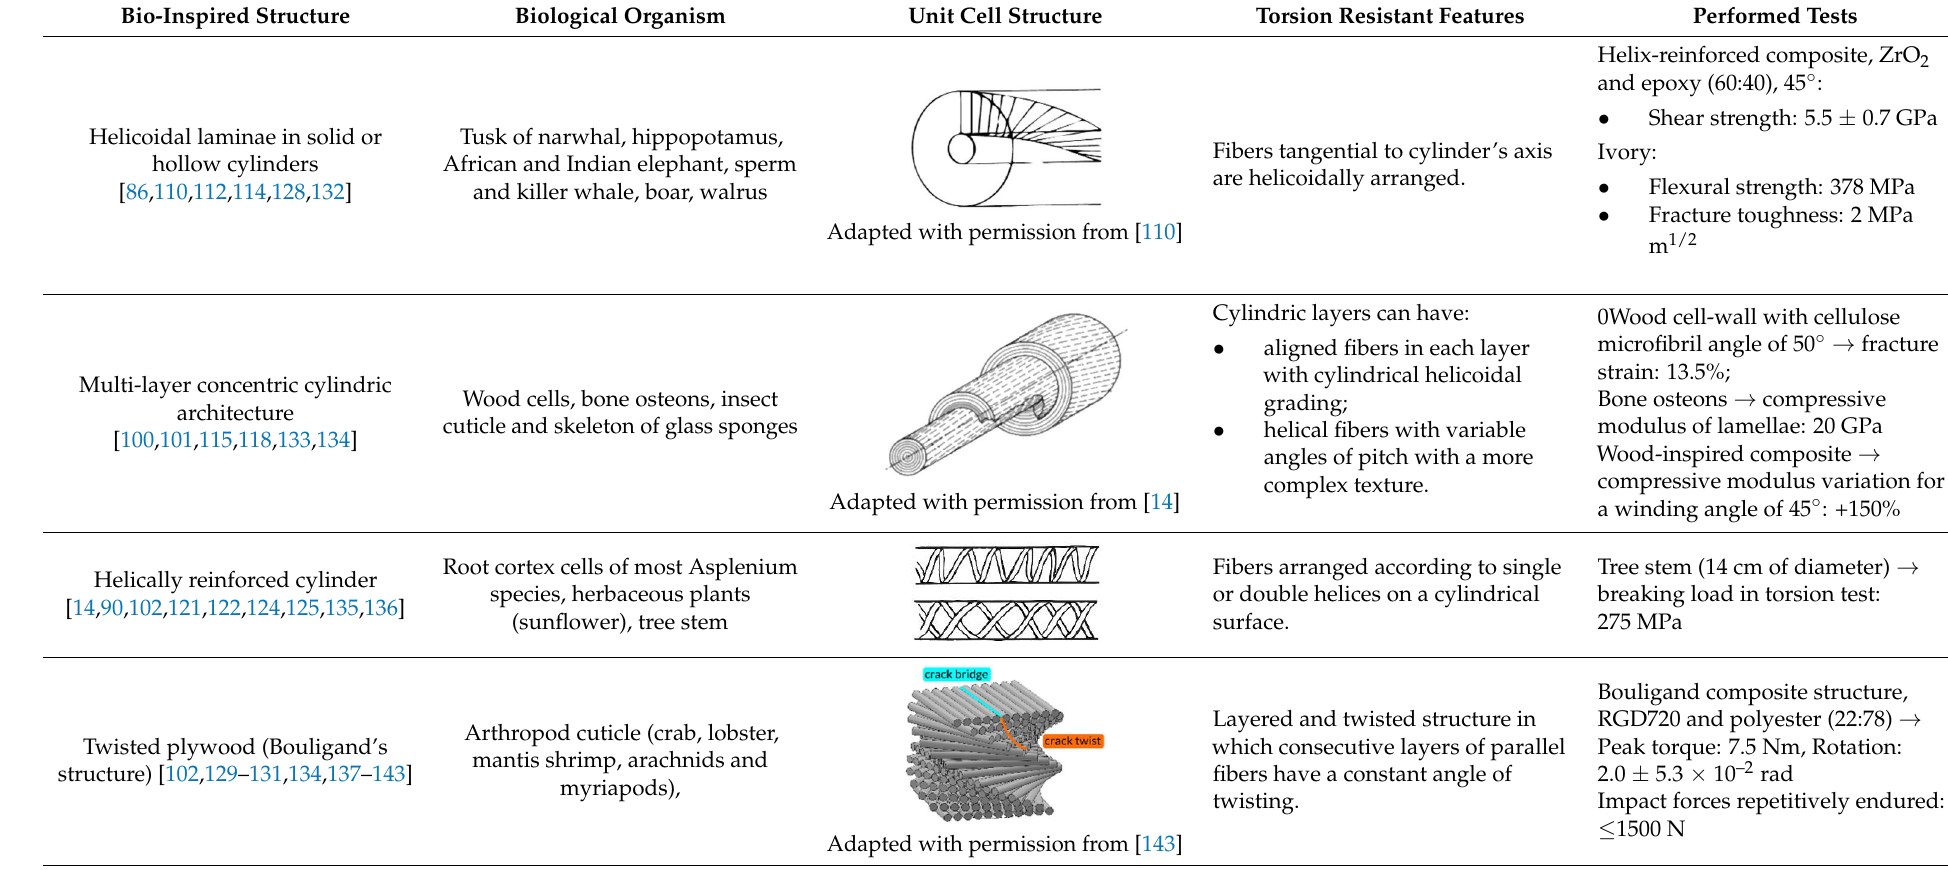
Table 2. Torsion-resistant biomimetic unit cells are selected, the biological source, and the schematic of the structure is reported. Additionally, specific torsion-resistant features are highlighted, in accordance with the performed mechanical/numerical tests.